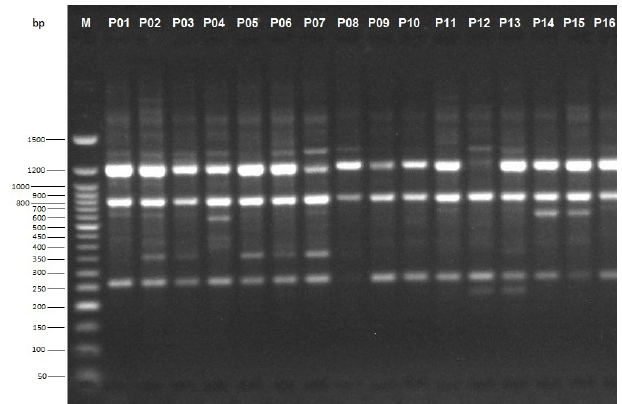
Figure 6. RAPD-PCR analysis of Parkia biglobosa accessions as revealed by primer OPB10. Accessions are numbered as in Table 1. M is the molecular size marker.